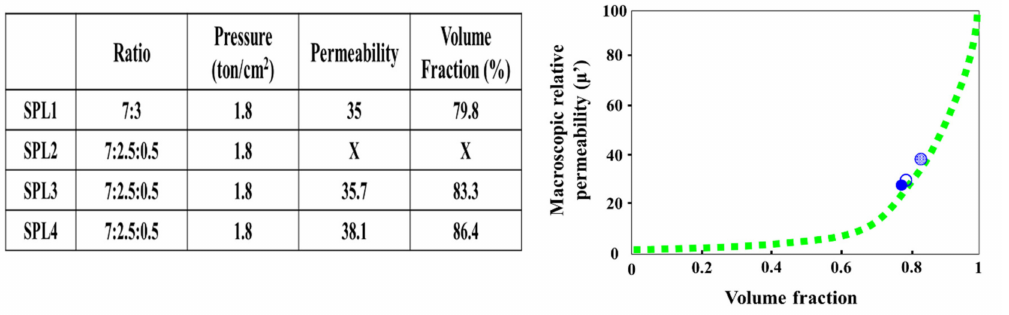
Figure 7. Permeability and volume fraction evaluation results of magnetic bulk composites by surface-treatment conditions of